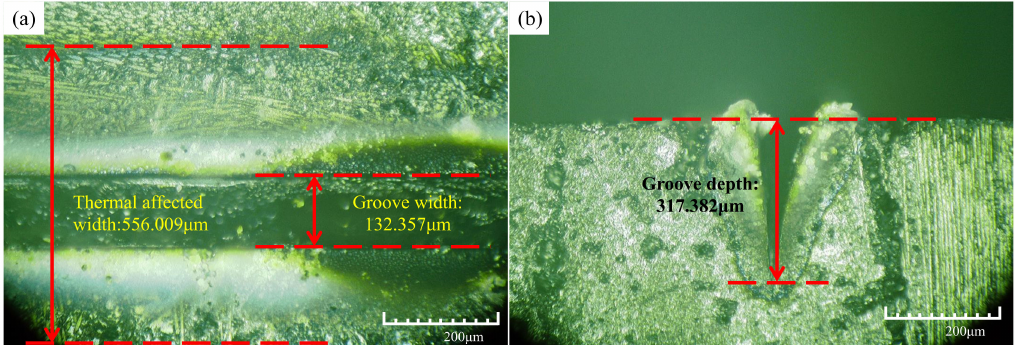
Figure 4. 3D-microscopic image with measured sizes (( a ). thermal affected width and groove width; ( b ). groove